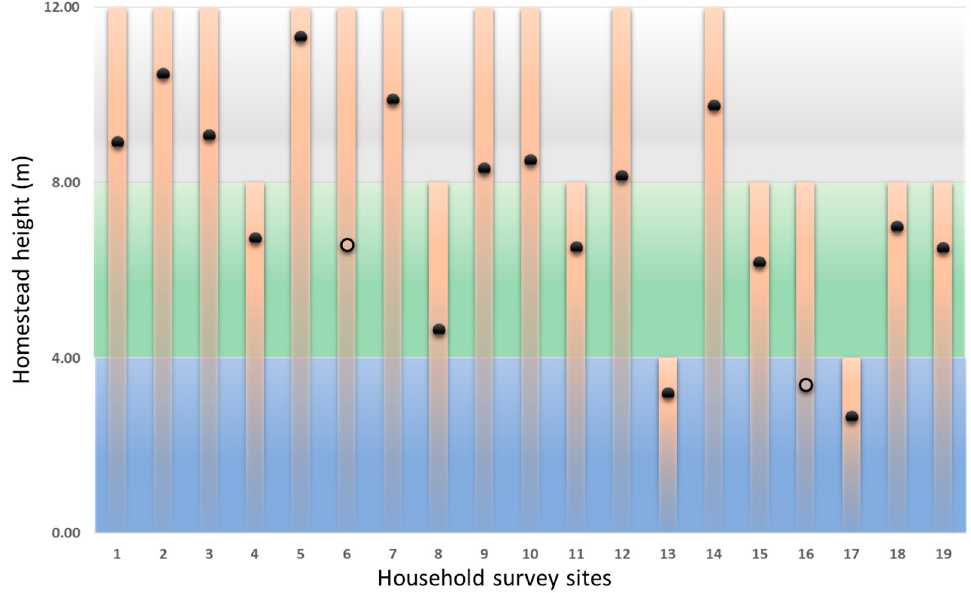
Figure 7. Consistency between the number of floors recorded in the household survey and the number of floors estimated with the proposed technique. The bars show the number of floors surveyed, while the scatter plot represents the calculated homestead floor heights. The black dots indicate that the estimated number of floors is consistent with the number of floors recorded in the survey, and the hollow dots indicate inconsistency. The blue, green, and gray regions in the background represent the number of floors (ground, two, and three) of the homestead,